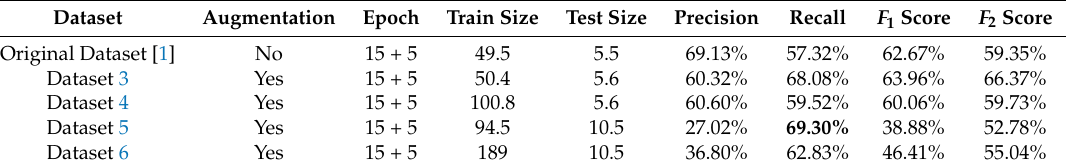
Table 5. The results of the effect of augmentation